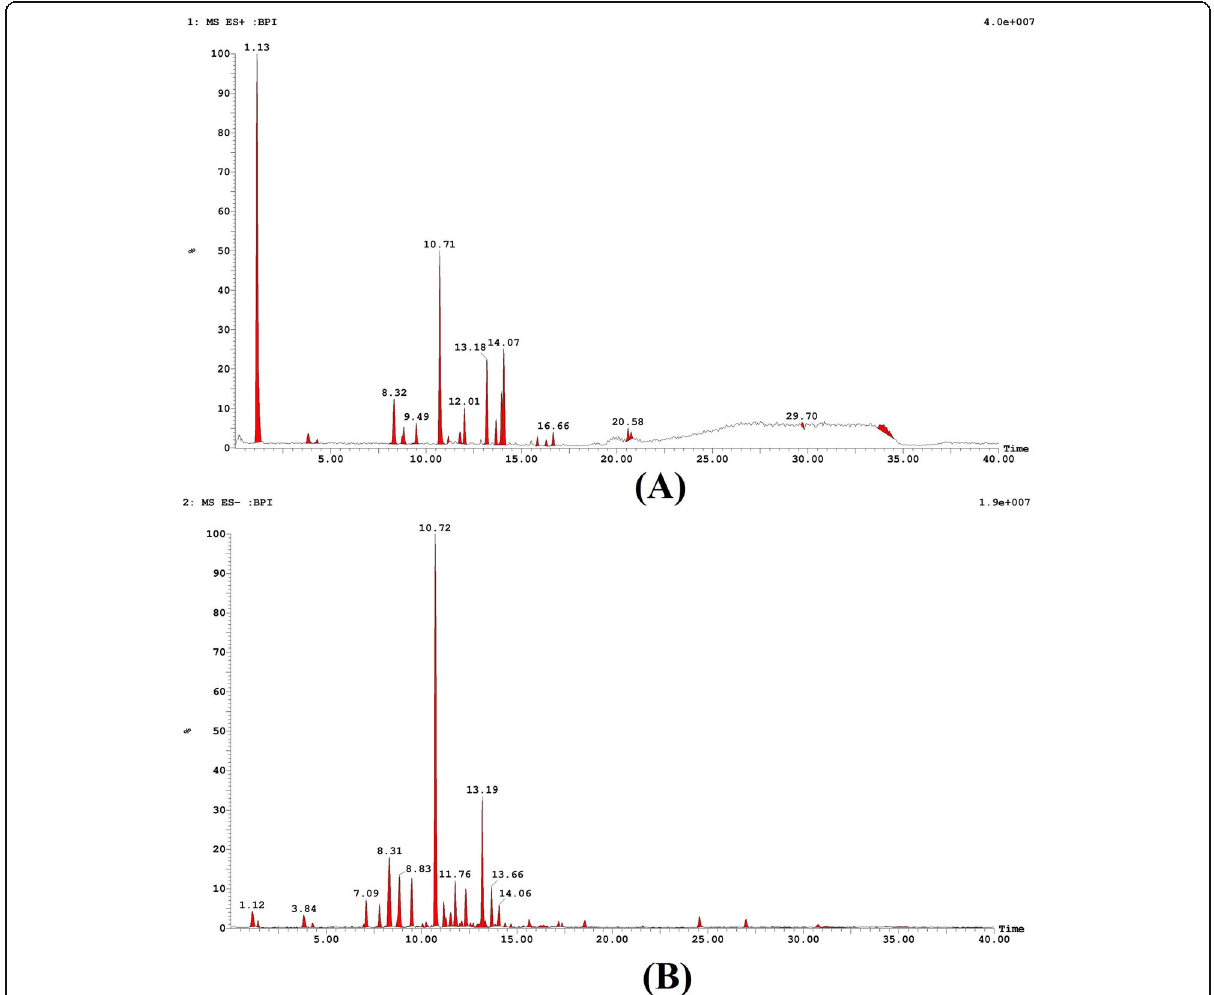
Fig. 6 Basic Peak Chromatogram of methanolic extract of Andrographis paniculata whole plant: A positive ion mode, B Negative ion